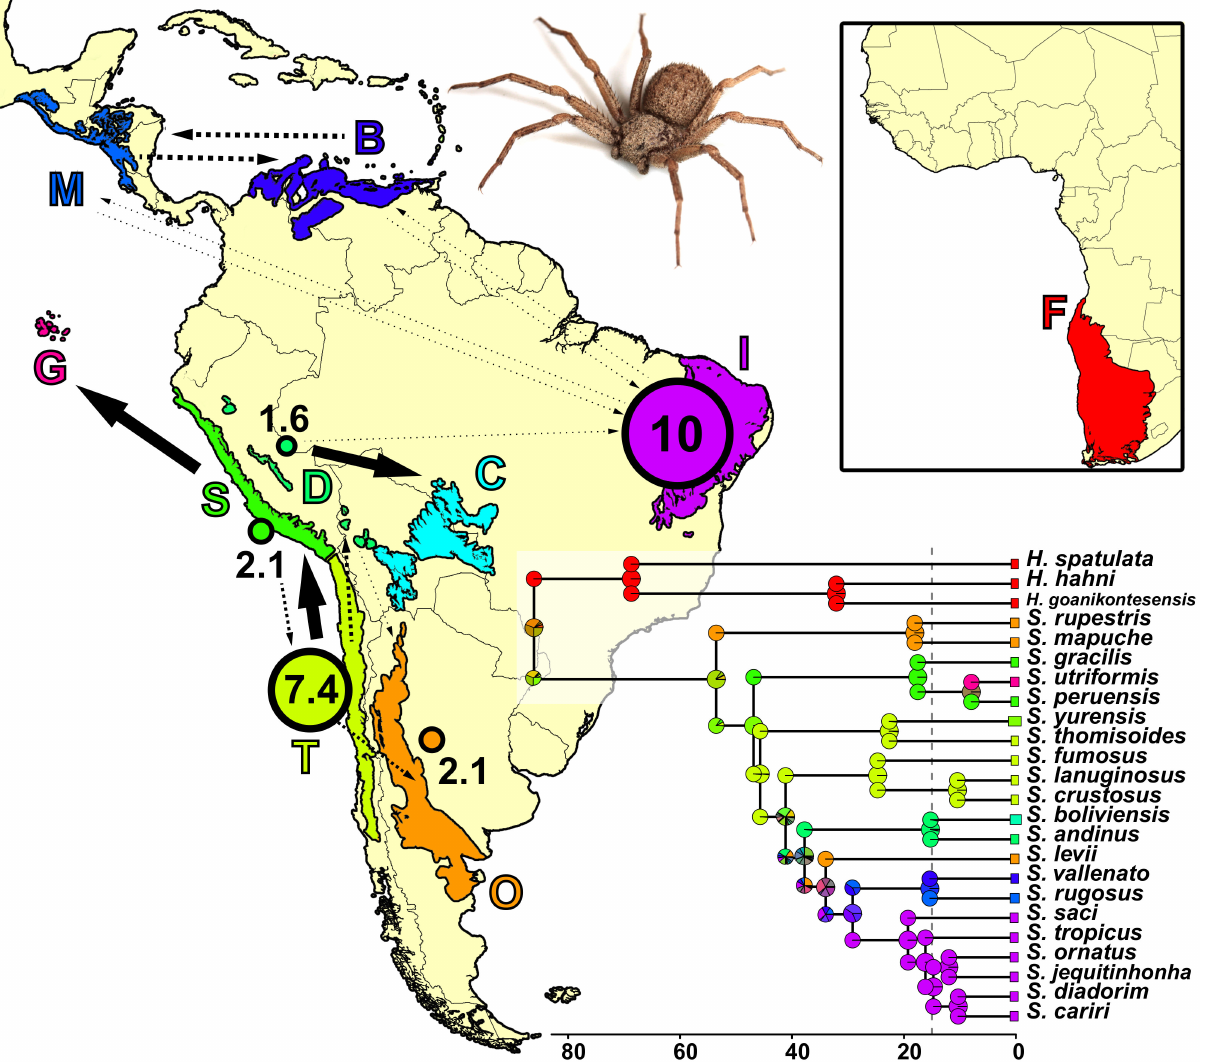
Figure 2. Map depicting the areas inhabited by Sicarius and Hexophthalma , and the ancestral range estimates under DIVA-like using the maximum clade credibility tree. Solid arrows among areas represent one dispersal event between areas that is robust to topological and biogeographical uncertainty. Dashed lines represent inferred dispersal events that are sensitive to uncertainty; arrow widths are proportional to the frequency at which such dispersals are inferred. Numbered circles indicate the inferred number of within-area speciation in each of the areas. Area abbreviations: B = dry forests in the Caribbean coast of Colombia; F = southern Africa deserts and xeric scrublands; C = Chiquitano dry forests in Bolivia; D =Andean dry forests; G = Galapagos Islands; I = Caatinga dry forest in Brazil; M = Mesoamerican dry forests; O = Argentinean Monte; S = Sechura desert in the Peruvian coast; T = Atacama Desert and neighboring Chilean xeric scrublands. Africa not to